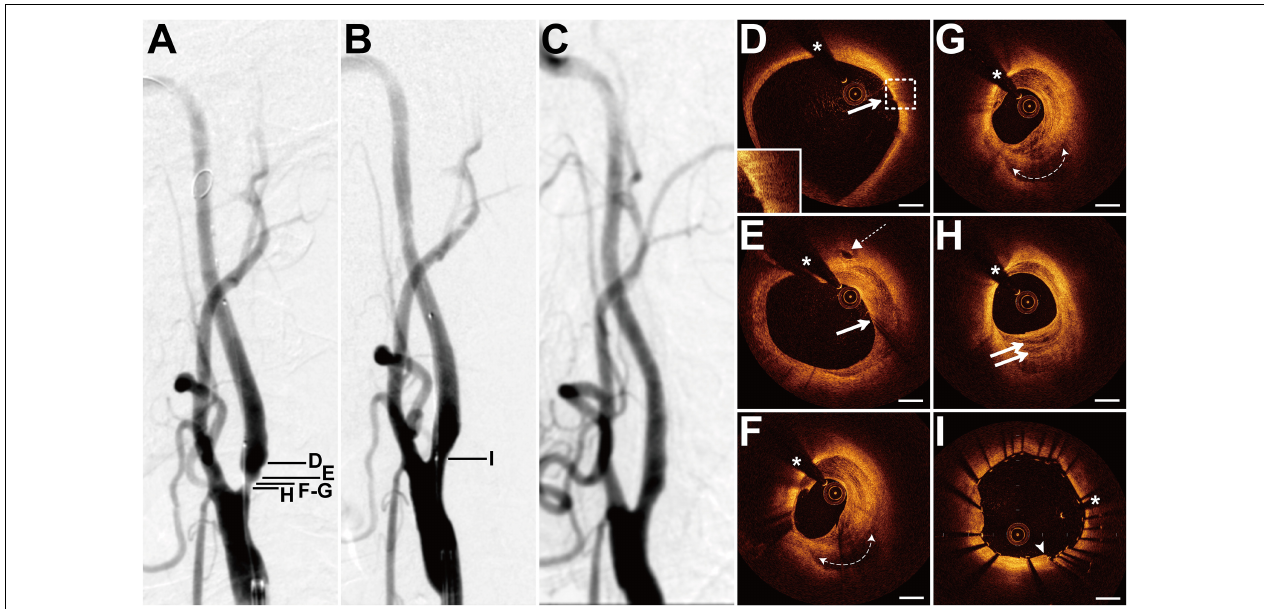
FIGURE 1 | DSA and OCT findings of the LICA lesion. Case 1. (A) The angiogram before stenting showed severe stenosis at the LICA sinus. (B) The angiogram after stenting. (C) The angiogram at a 4-month follow-up revealed no in-stent restenosis. (D) The macrophage accumulations (arrow) at 2 o’clock. (E) The microvessel (dashed arrow) at 12 o’clock and the heterogeneous signal-rich tissue (arrow) at 12–6 o’clock. (F,G) Adjacent OCT images. (G) The image with the minimum lumen. The heterogeneous tissue occupied 3/4 of the vessel and the irregular signal-poor tissue (dashed curve with arrows) accumulated at 5–7 o’clock. (H) The onion-like structure (double arrow). (I) Post-interventional OCT image with the minimum lumen. Stent struts were well apposed and there was smooth tissue protrusion (arrowhead) between stent struts. Scale bars represent 1 mm. Asterisks denote guide-wire artifact. DSA, digital subtraction angiography; LICA, left internal carotid artery; OCT, optical coherence